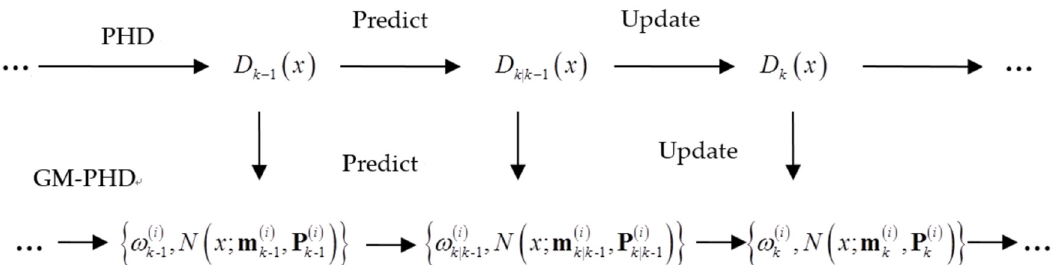
Figure 1. The space model of multi ‐ targets tracking.